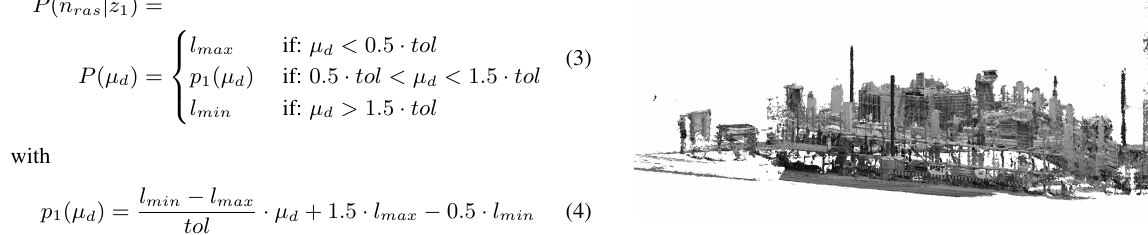
Figure 5. Point cloud for time step 1 on 15 May.